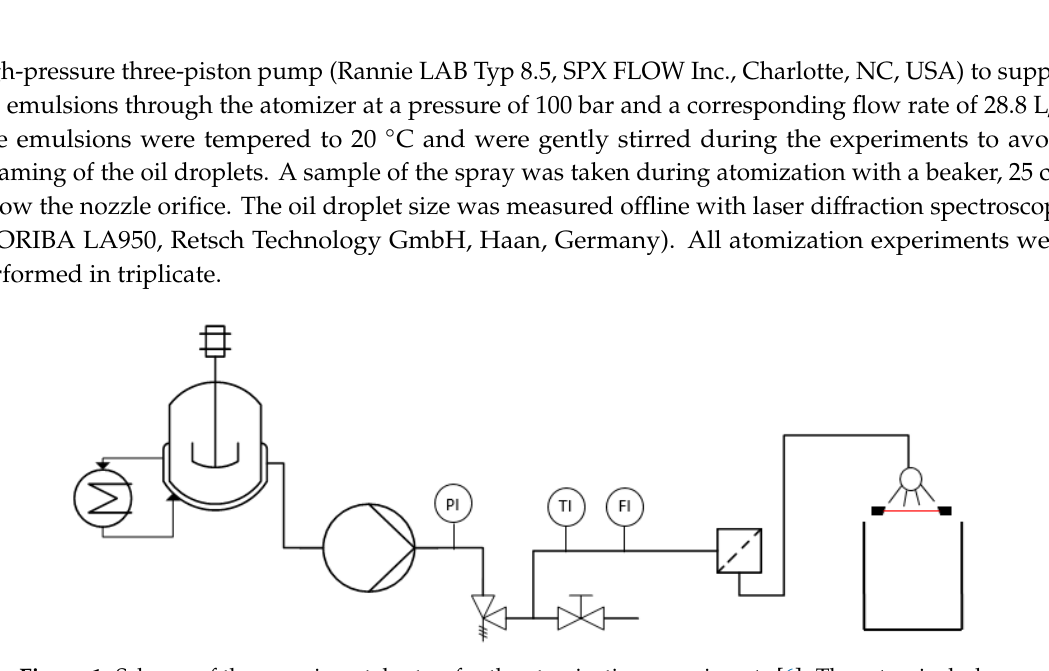
Figure 1. Scheme of the experimental setup for the atomization experiments [6]. The setup includes a tempered jacketed vessel; a high-pressure pump with a safety valve and an additional outlet valve; pressure, temperature, and volume flow sensors; a metal filter to avoid blockage of the nozzle orifice; a pressure swirl atomizer; a laser diffraction spectroscope for inline measurement of the spray droplet size; and a container to collect the emulsions after atomization.